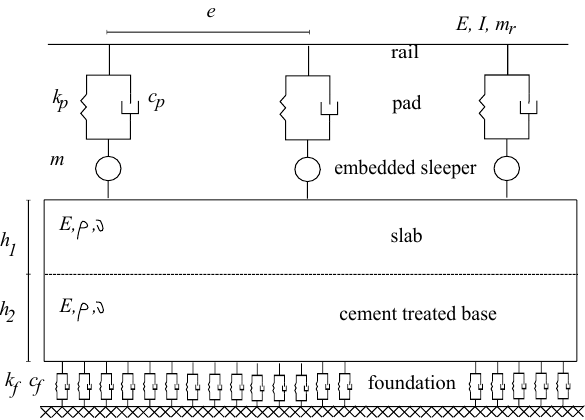
Figure 2. Track model of continuous slab systems.